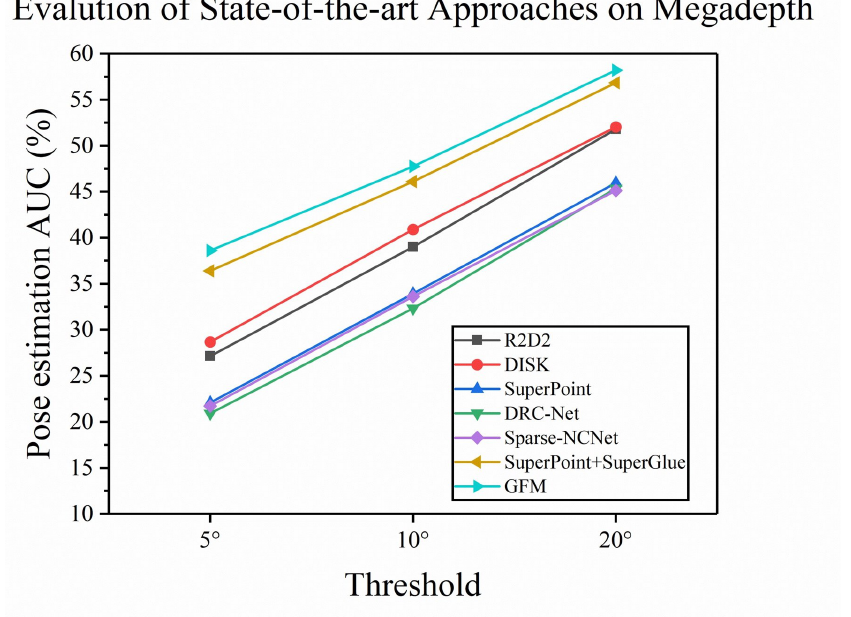
Figure 6. Pose estimation on MegaDepth. Different colors represent different methods, and we show the AUC values for each method at different pose error thresholds (5 ◦ , 10 ◦ , 20 ◦